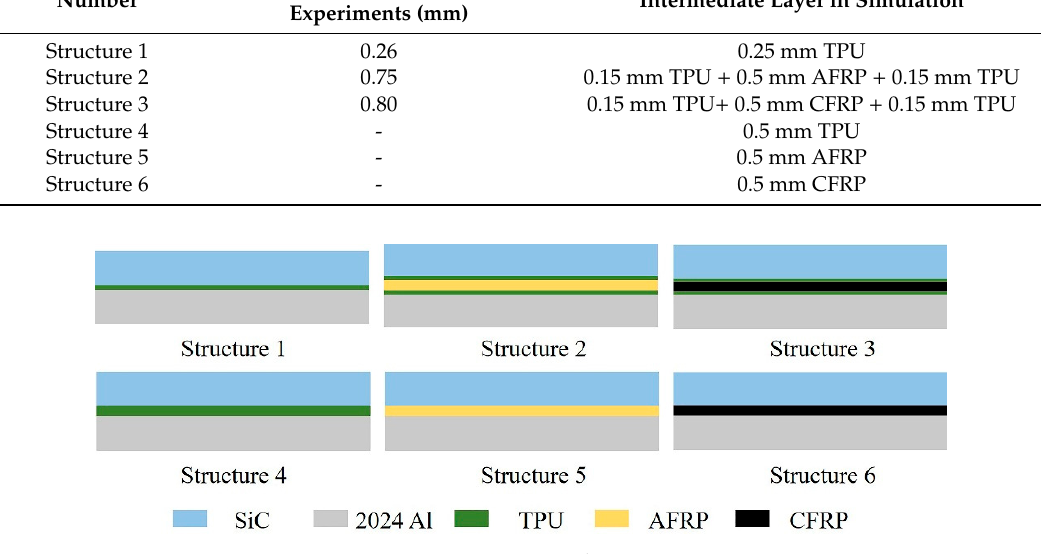
Figure 1. Structures diagram.